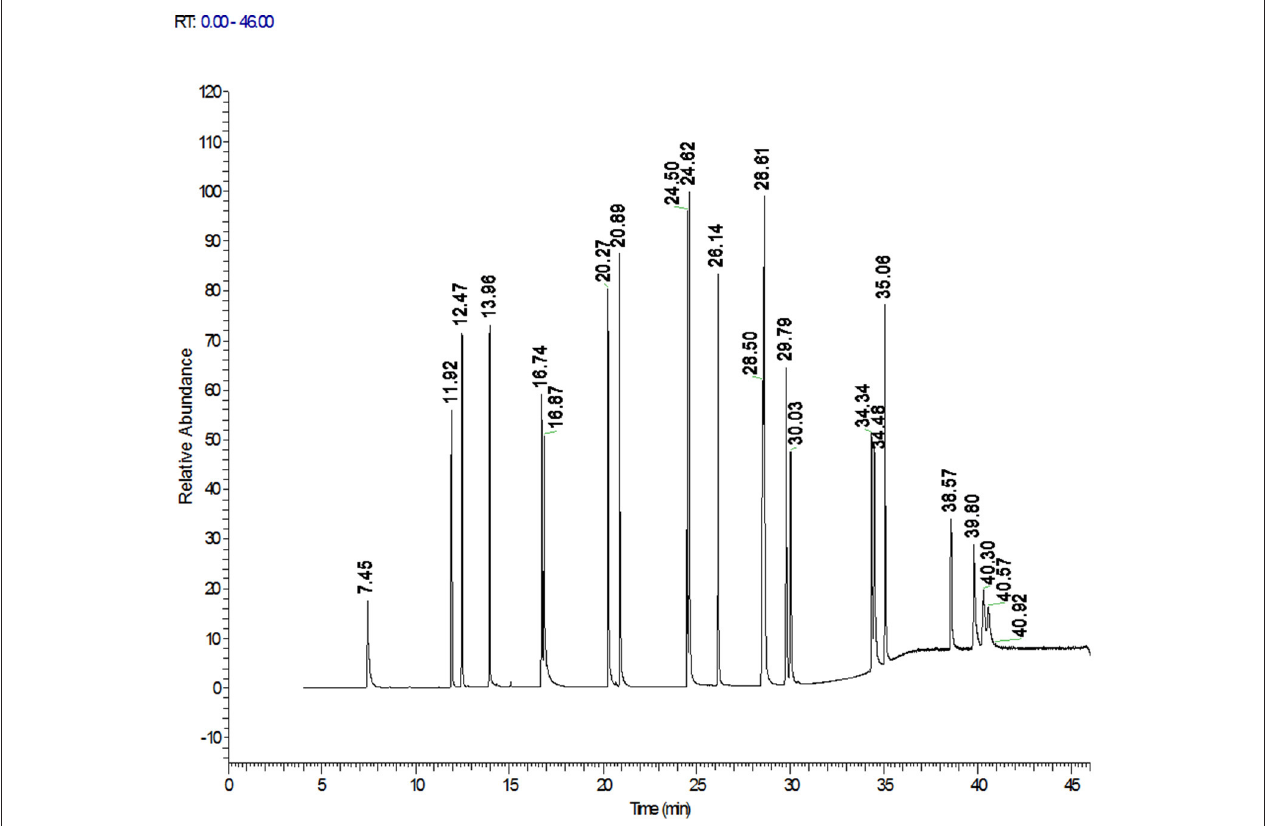
FIGURE 1 | Total ion chromatograms of the 22